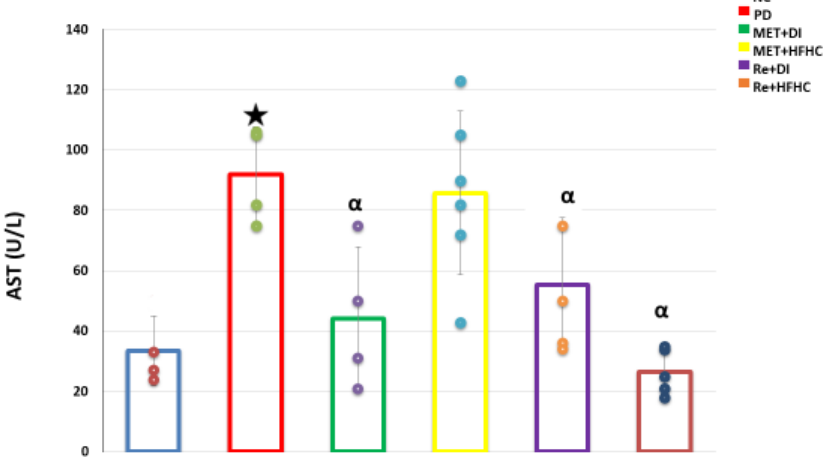
Figure 10. Plasma AST concentration in normal control (NC), prediabetic control (PD), metformin and diet intervention (MET + DI), metformin and high fat–high carbohydrate (MET + HFHC), rhenium (V) compound and diet intervention (Re + DI) and rhenium (V) compound and high fat–high carbohydrate (Re + HFHC) groups after 12 weeks of treatment. Values are presented as means ± SD and individual data points ( n = 6). * p < 0.05 by comparison with NC, α p < 0.05 by comparison with PD, MET + DI, MET + HFHC, Re + DI and Re + HFHC.